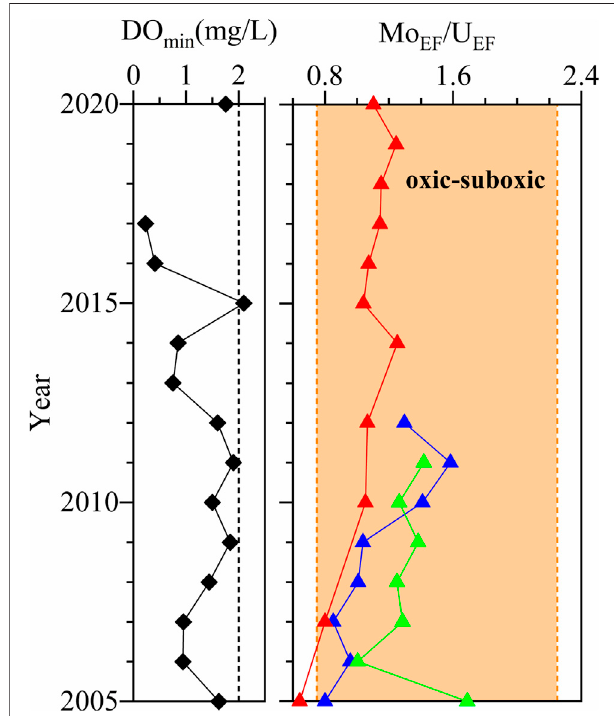
FIGURE 5 | Observation data of minimum DO concentrations in the hypoxic zone off the Changjiang River Estuary and down-core variations of Mo EF /U EF valuesinsedimentcore3,050 – 2(red), E3(green),andE4(blue)(Wu et al., 2020; Liu et al., 2021). Orange dashed lines represent 0.1 and 0.3 × Mo/U modern seawater , and the orange shadow indicates an oxic – suboxic environment.